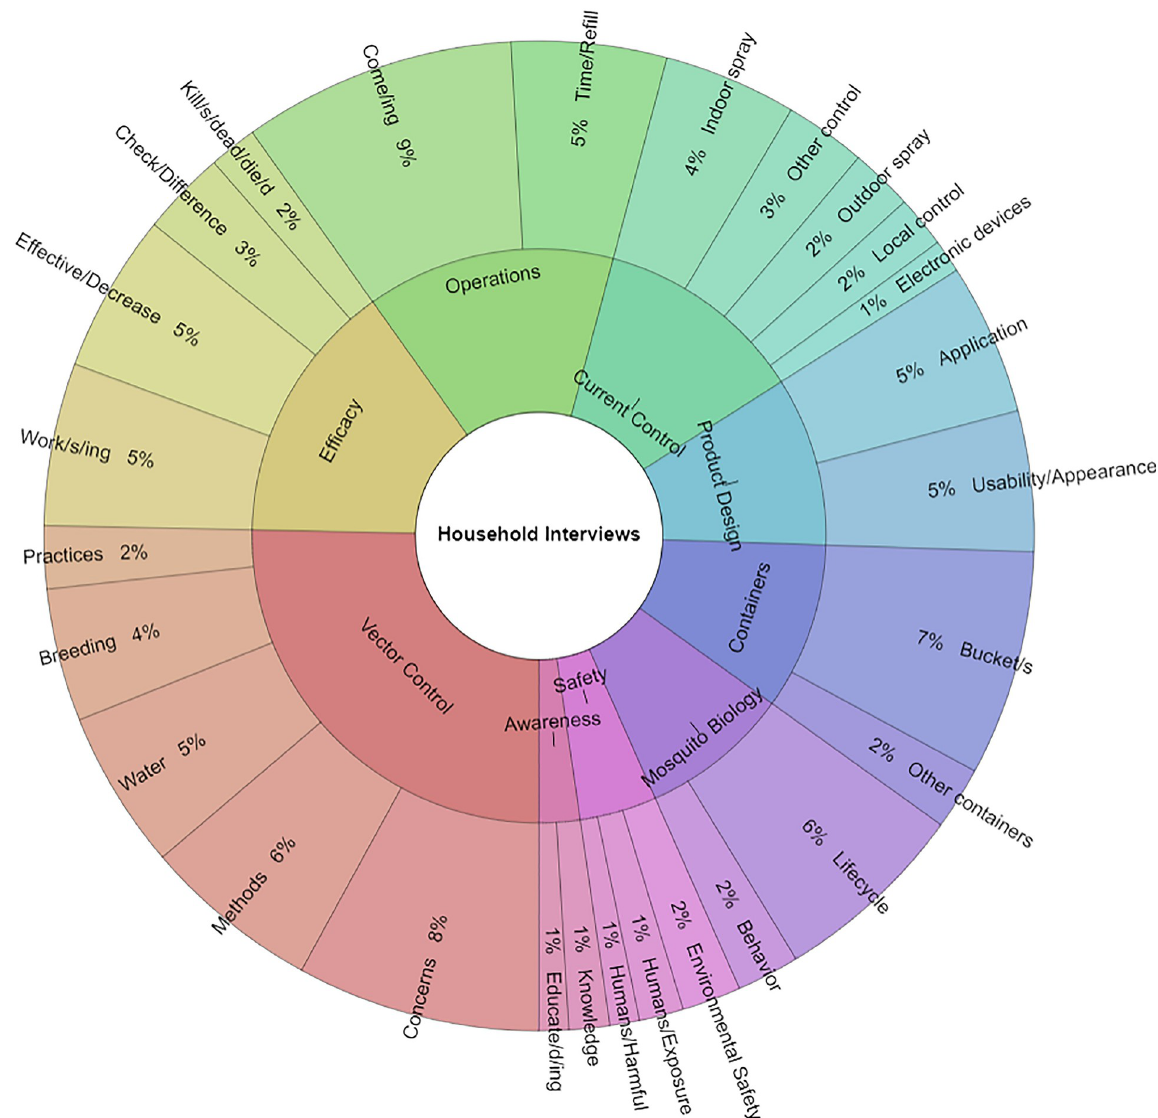
Fig 6. Krona chart summarizing words that were frequently repeated during interviews. Textual analysis revealed words that were frequently repeated by homeowners during the interview study. The chart was generated with Krona Excel Template v.2.5